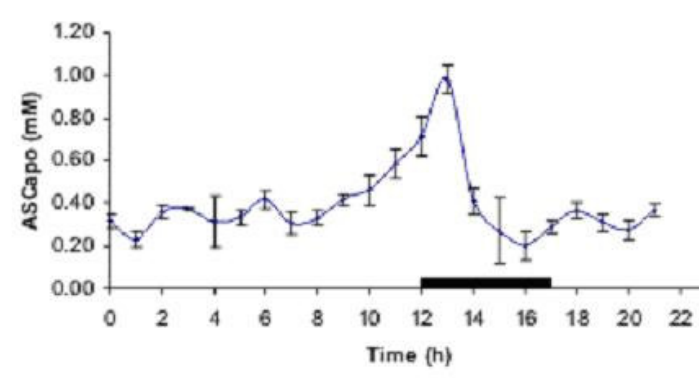
FIGURE 4. Reduced apoplastic ascorbic acid (ASC apo ), 24-h profile. Vertical bars indicate ± SE. Horizontal thick bar indicates the period of maximum values of ozone. Time is set from 0 to 23 h. n =